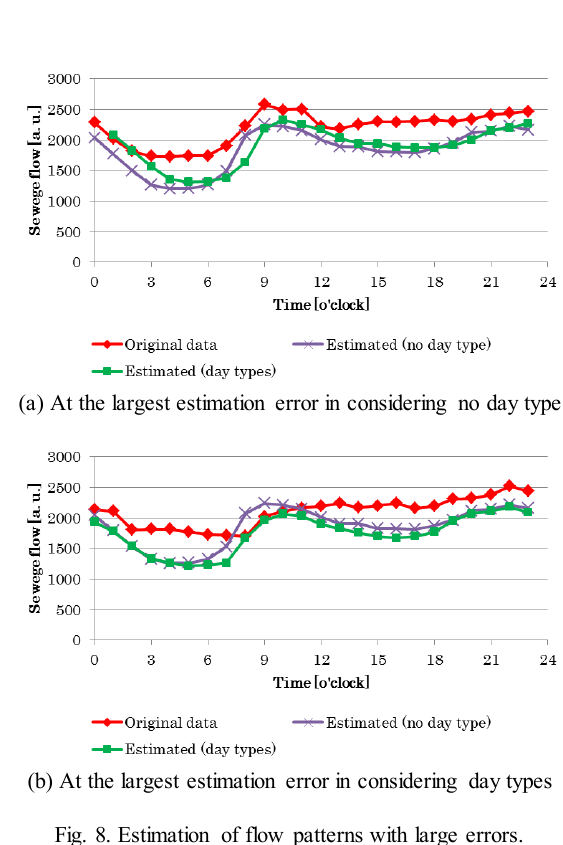
Fig. 8. Estimation of flow patterns with large